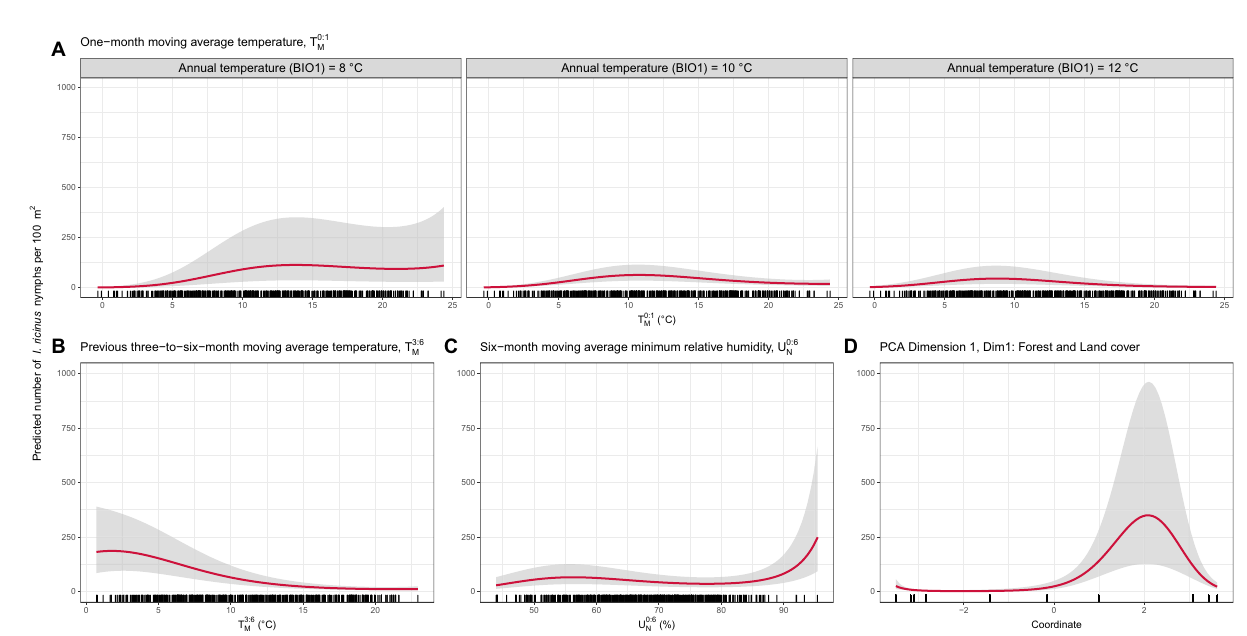
Figure 7. Predicted effects of environmental factors on the number of I. ricinus nymphs per 100 m 2 given the average values of all other variables: ( A ) 1-month moving average temperature, an averaged mean temperature 0 : 1 between previous 30 days and sampling day ( T M ) with an interaction effect with annual temperature ( BIO 1 Temp ); ( B ) previous 3-to-6-month moving average temperature, an averaged mean temperature between 3 : 6 3 and 6 months prior to the sampling day ( T M ), ( C ) 6-month moving average minimum relative humidity, an 0 : 6 averaged minimum relative humidity between previous 6 months and the sampling day ( U N ); ( D ) coordinates on Dimension 1 of the principal component analysis ( Dim 1 ), representing forest and land cover characteristics. Gray shaded areas indicate a 95% confidence interval. Rugs display the distribution of observed